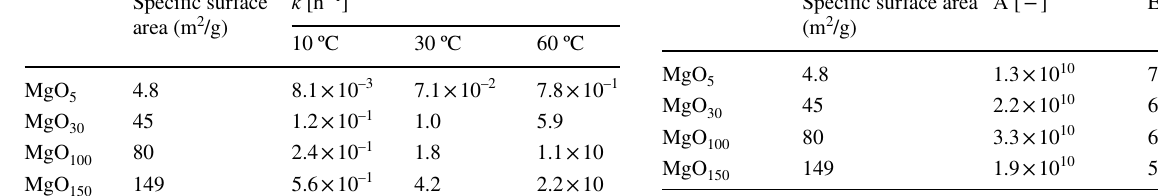
Table 5 Reaction rate constant for fluorine removal at each tempera- ture for each MgO Specific surface area (m 2 /g)